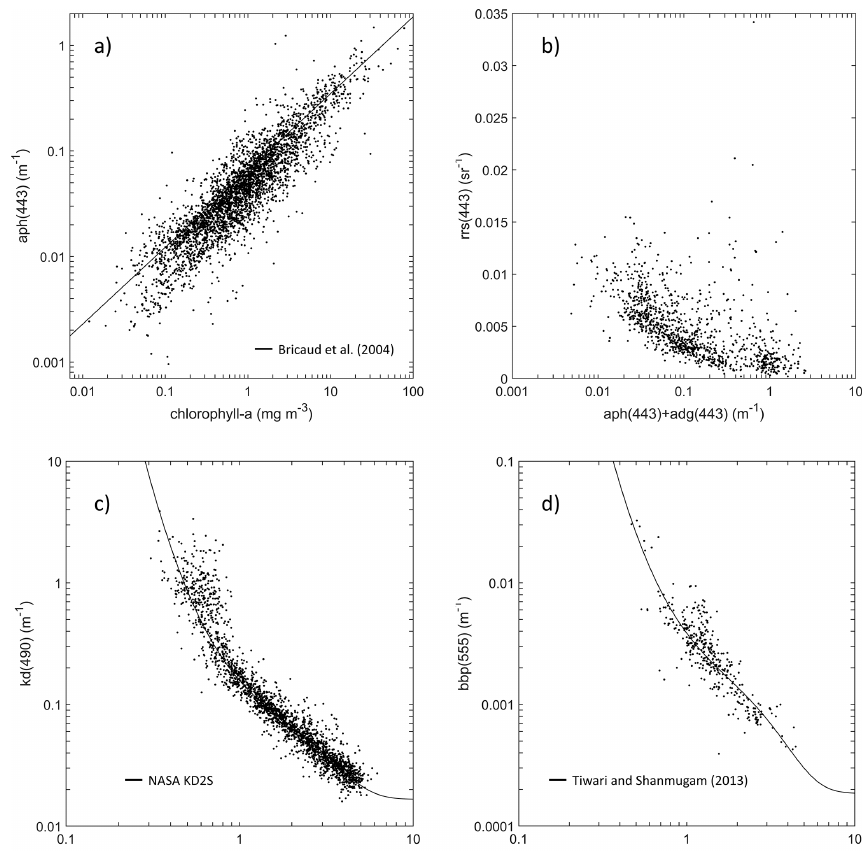
Figure 16. Examples of bio-optical relationships in the final merged table: (a) aph(443) versus chlorophyll- a . Total number of points (3387) is divided between AWI (753), COASTCOLOUR (335), MERMAID (214), NOMAD (991), SeaBASS (139), and TPSS (955). For reference, the solid line shows the regression from Bricaud et al. (2004). (b) [aph(443) + adg(443)] versus rrs(443). Total number of points (1112) is divided between MERMAID (33) and NOMAD (1079). (c) [rrs(490) / rrs(555)] versus kd(490). The total number of points (2280) is divided between MERMAID (62), NOMAD (2117), and SeaBASS (101). For reference, the solid line shows the NASA KD2S standard algorithm (https://oceancolor.gsfc.nasa.gov/atbd/kd/, last access: 18 December 2022). (d) [rrs(490) / rrs(555)] versus bbp(555). The total number of points (365) is divided between MERMAID (33), NOMAD (324), COASTCOLOUR (4), and SeaBASS (4). For reference, the solid line shows the relation proposed by Tiwari and Shanmugam (2013). A search window of 2nm was used for (a) and (b) , and a search window of 5nm was used for (c) and (d) to include data at 560nm when not available at